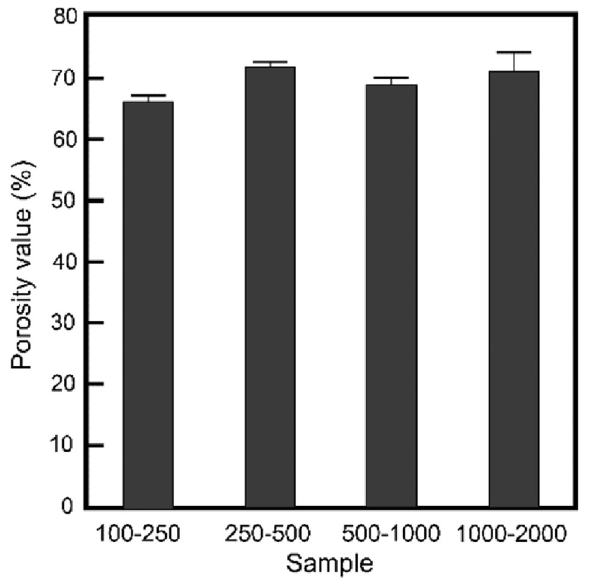
Fig. 7 Porosity values obtained for the OCP-Ag foams as a function of initial granule